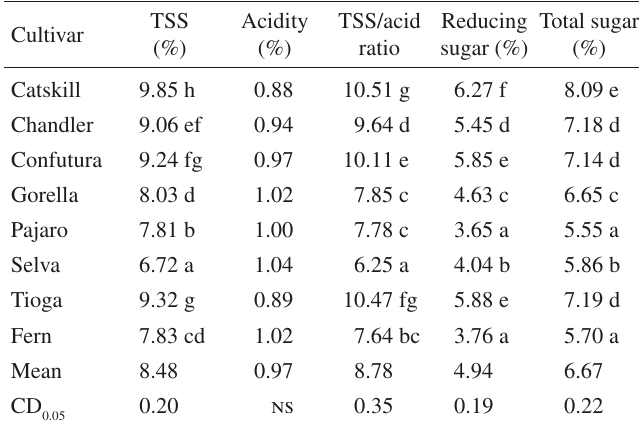
Table 3 - Biochemical characters of strawberry cultivars under poly- house